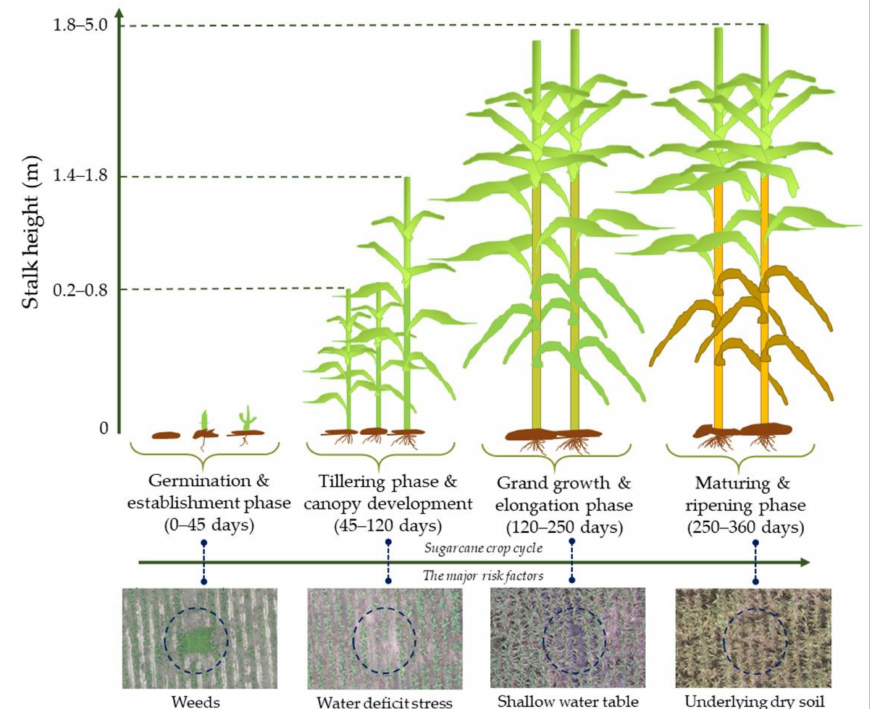
Figure 1. Sugarcane crop cycle and main phenological phases. The illustration has been adapted from Molijn et al. [44] and NaanDanJain Irrigation Ltd. [60]. Additionally included are RGB aerial views from drone-mounted camera (source: UAV DJI phantom 3 professional captured in 2018) as well as an indication regarding the major risk factors per phenological